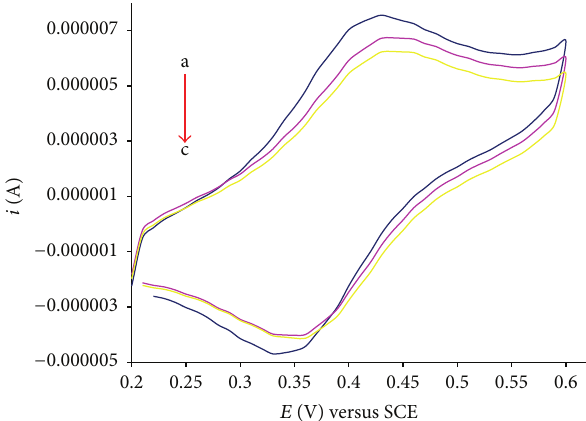
Figure 1: Cyclic voltammograms of 1mM compound Ft recorded at 100 mV/s potential sweep rate on glassy carbon electrode at 25 ∘ C in the absence (a) and presence of 1mL of 20 𝜇 M, 40 𝜇 M with increasing concentration of CT-DNA (b-c) in 20% aqueous DMSO buffer at pH 7.0; supporting electrolyte 0.1 M KCl.